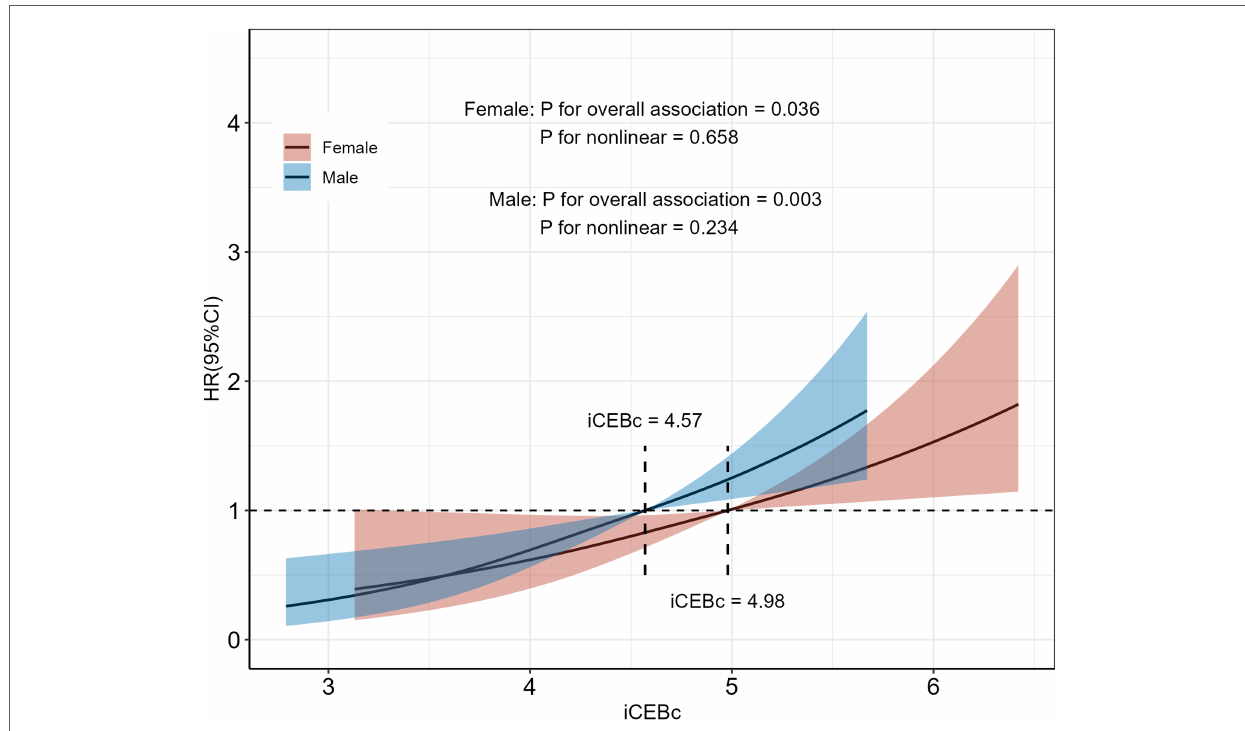
FIGURE 2 Restricted cubic spline of the association between iCEBc and All-cause death. Participants were divided into two groups according to the iCEBc cut-off value (male: 4.57, female: 4.98). HR, hazard ratio; 95% CI, 95% con fi dence